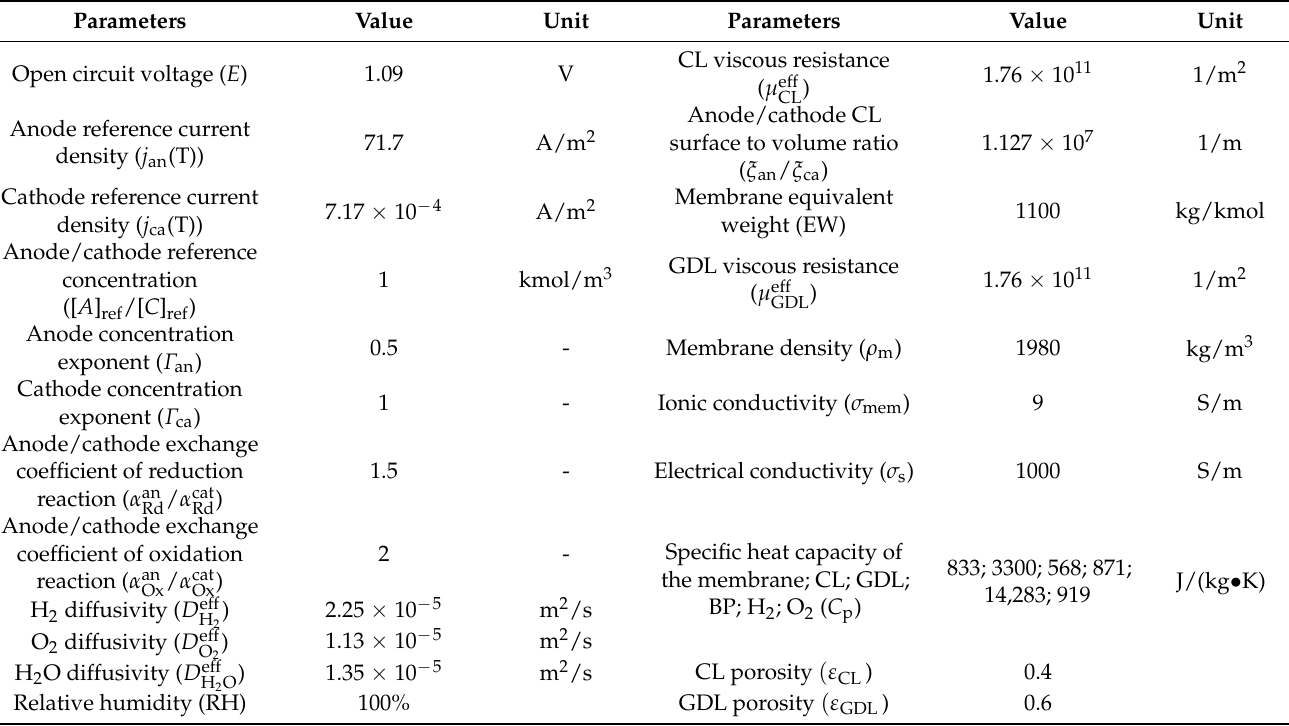
Table 5. Boundary conditions and material properties